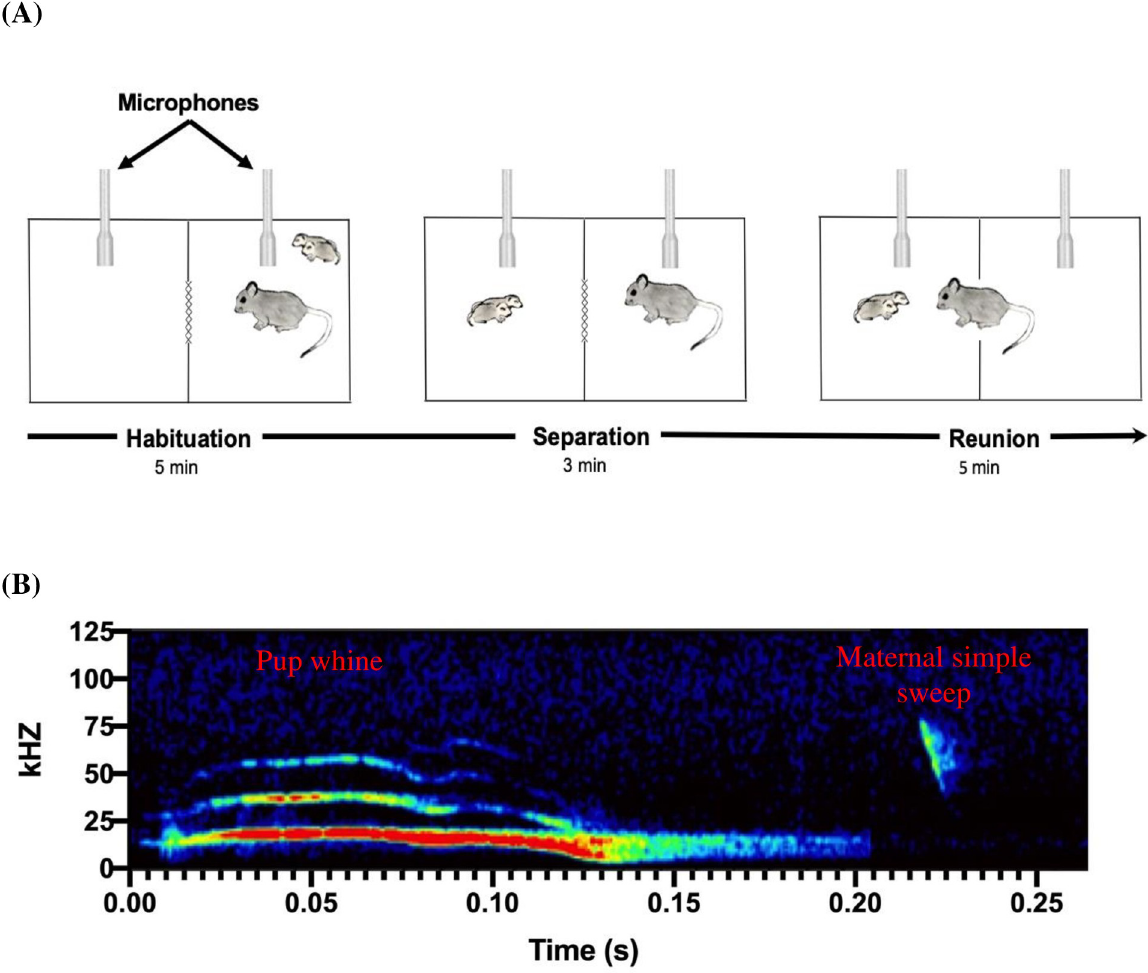
Fig 1. (A) Schematic for experimental design. Mother and pup (PND 2–3) groups were temporarily removed from their home cage and placed in the right side of two-chambered apparatus (five min) to habituate to the testing arena. Next, pups were moved from the right chamber and placed into the left chamber (three min). Lastly, the researchers lifted the mesh gate separating the right and left chambers, allowing mother-pup interactions (five min). Animals not to scale in diagram. (B) Ultrasonic vocalizations (USVs) on a spectrogram. Pup whines have multiple harmonics, a peak frequency around 20 kHz, and downward modulation at the end of the call that distinguish these calls from adult syllable vocalizations. Maternal simple sweeps have short downward-sweeping vocalizations that sweep through multiple frequencies, typically between 80 kHz and 40